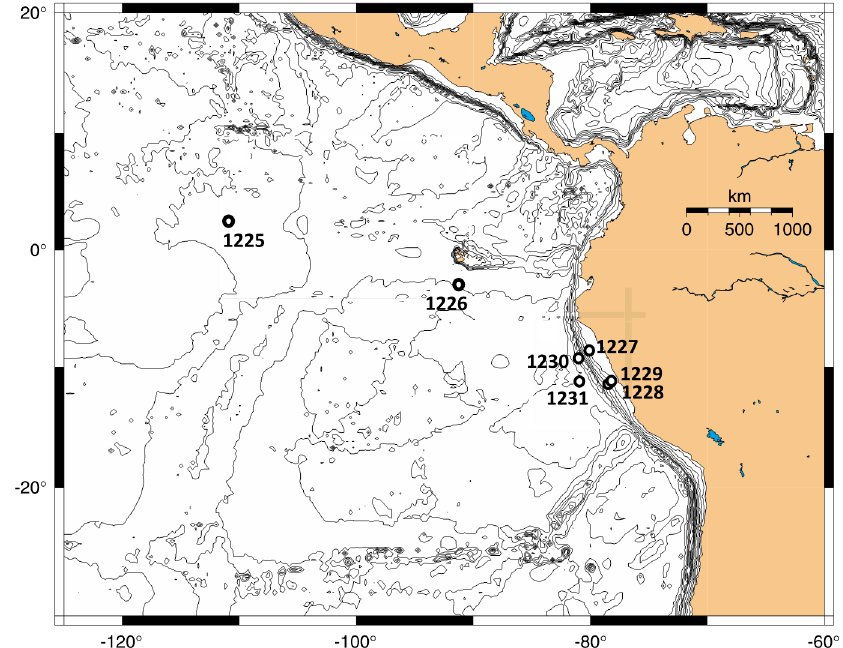
Figure 1. ODP Site 1225 in the eastern equatorial Pacific, and other drilling sites of ODP Leg 201 near Galapagos (1226), on the Peru Margin (1227 to 1229), in the Peru Trench (1230), and Peru Basin (1231). Modified from [7].